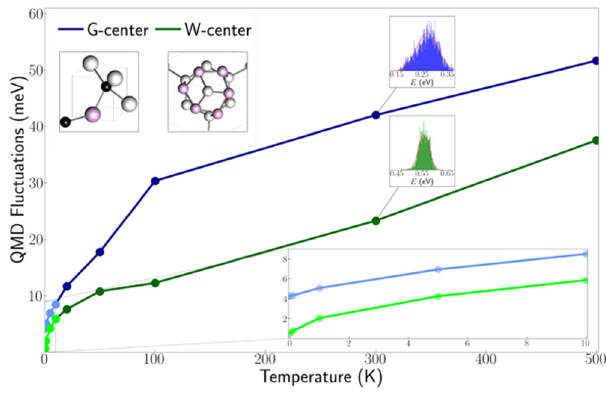
Fig. 9 Quantum Molecular Dynamics (QMD) simulations for W and G-centers vs. simulation temperature, which represents local disorder. The G-center shows a higher sensitivity to disorder than the W-center, in agreement with experimental results. Insets (top left) show G and W-center structures with C-atoms in black, Si-atoms in gray, and defect (interstitial) Si-atoms in pink. Each point in the plot represents ~5000 con fi gurations obtained through QMD. Inset (bottom right) shows a magni fi ed region of the plot for 0 – 10 K. Sample histograms (top right) of this data are shown at 300 K for both defect